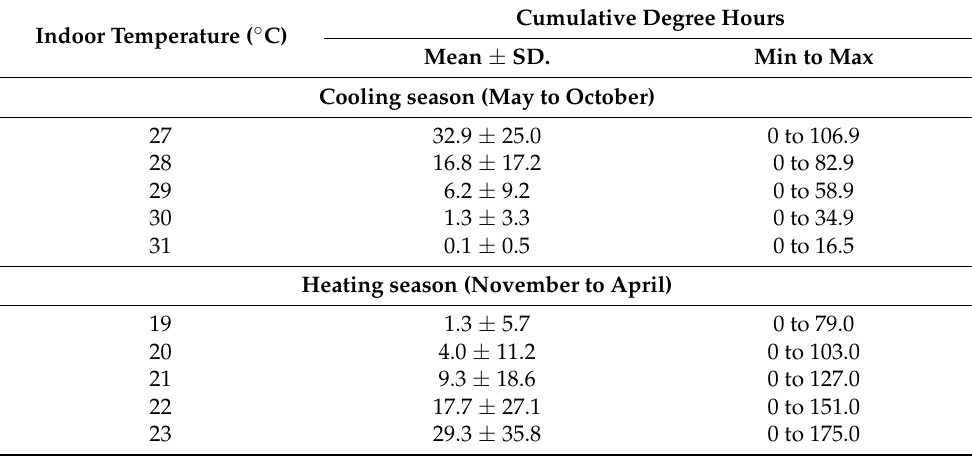
Table 1. Summary of cumulative degree hours from 2006 to 2014 in different